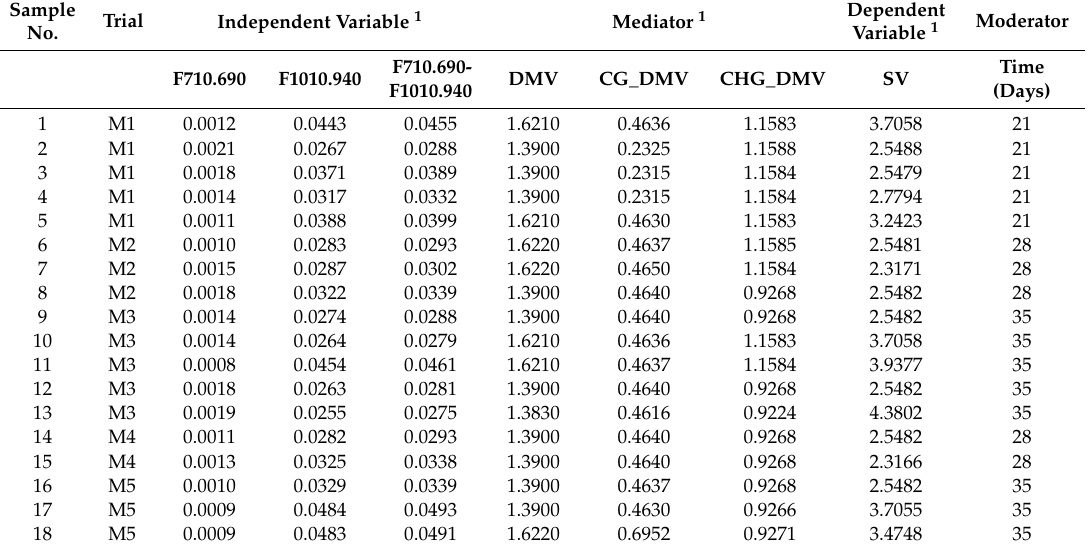
Table 1. Quantitative metAFLP characteristics and corresponding infrared spectroscopy data of barley regenerants derived by in vitro tissue culture under nine di ff erent trials (M1–M9). Sample